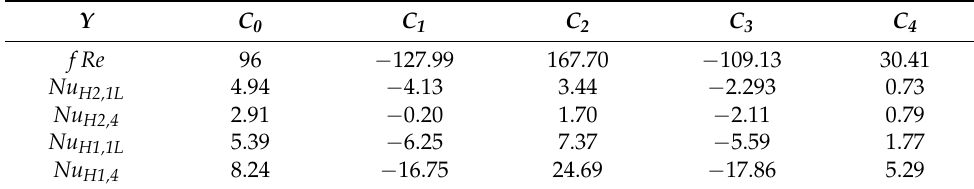
Table 1. Coefficients in polynomial Equation